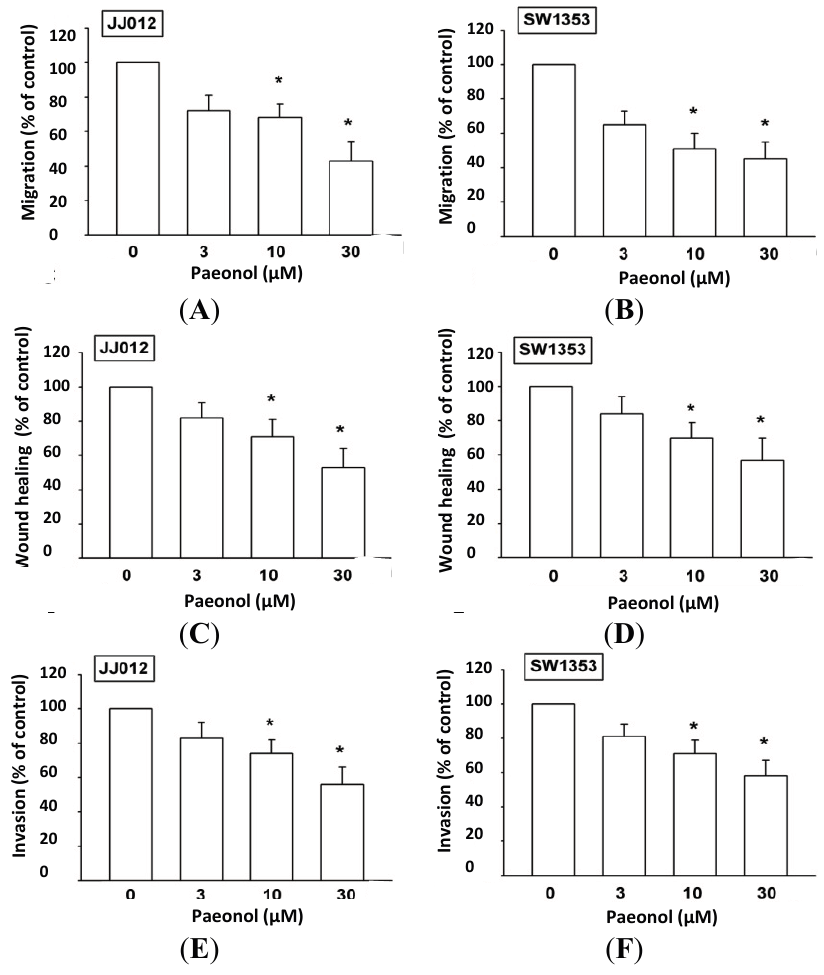
Figure 2. Paeonol inhibits migration and invasion of human chondrosarcoma. ( A – F ) Cells were incubated with various concentrations of paeonol for 24 h; cell migration and invasion was examined through Transwell ( n = 5), wound healing ( n = 4), and